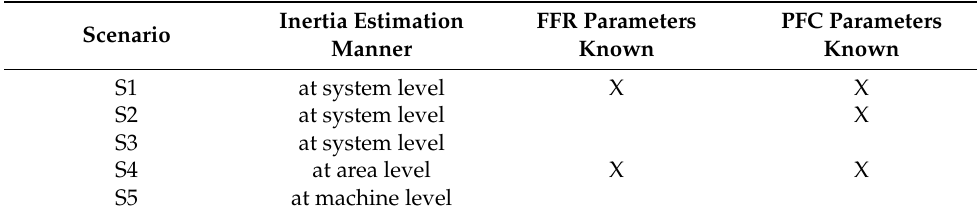
Table 3. Summary of the different scenarios used for estimating the overall inertia of systems with mixed